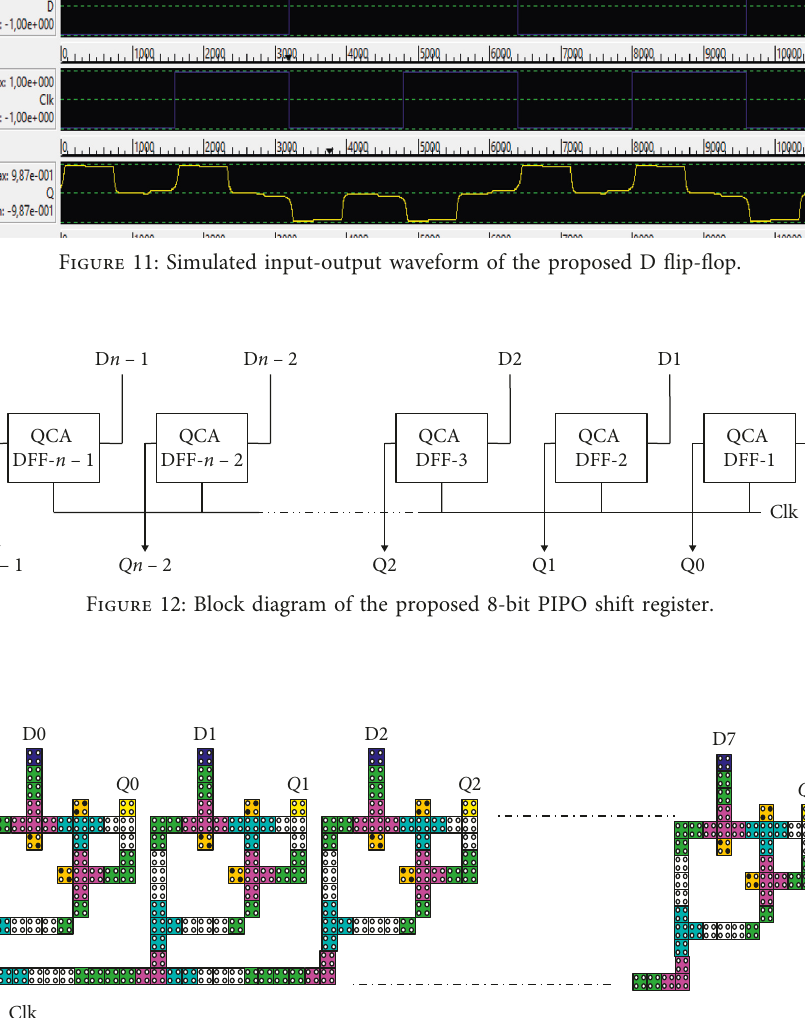
Figure 13: QCA layout of the 8-bit PIPO shift